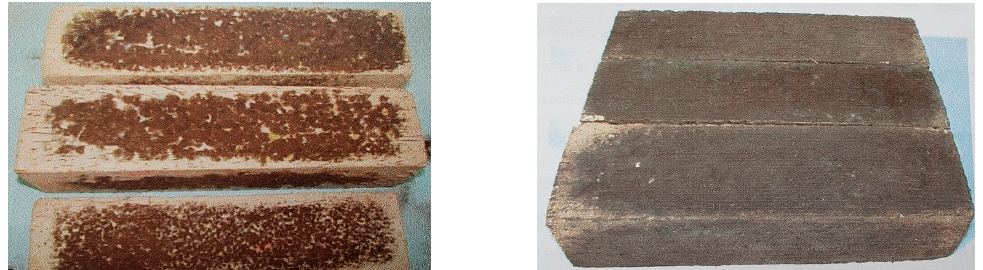
Figure 6. Mildew grows on the surface of the oil palm lumber and discolors the affected specimen to black. Lim and Khoo identified that the moisture content in oil palms increases with the increasing amount of parenchyma tissue from the periphery to the center and from the stem base to the top until 400% [60]. Parenchyma cells are a suitable substrate for many microorganisms [61]. Therefore, as with other lignocelluloses, the felled trunk, with its high parenchyma and moisture content, is susceptible to the colonization by mildew fungi until the wood has dried down below the fiber saturation of approximately 30% moisture